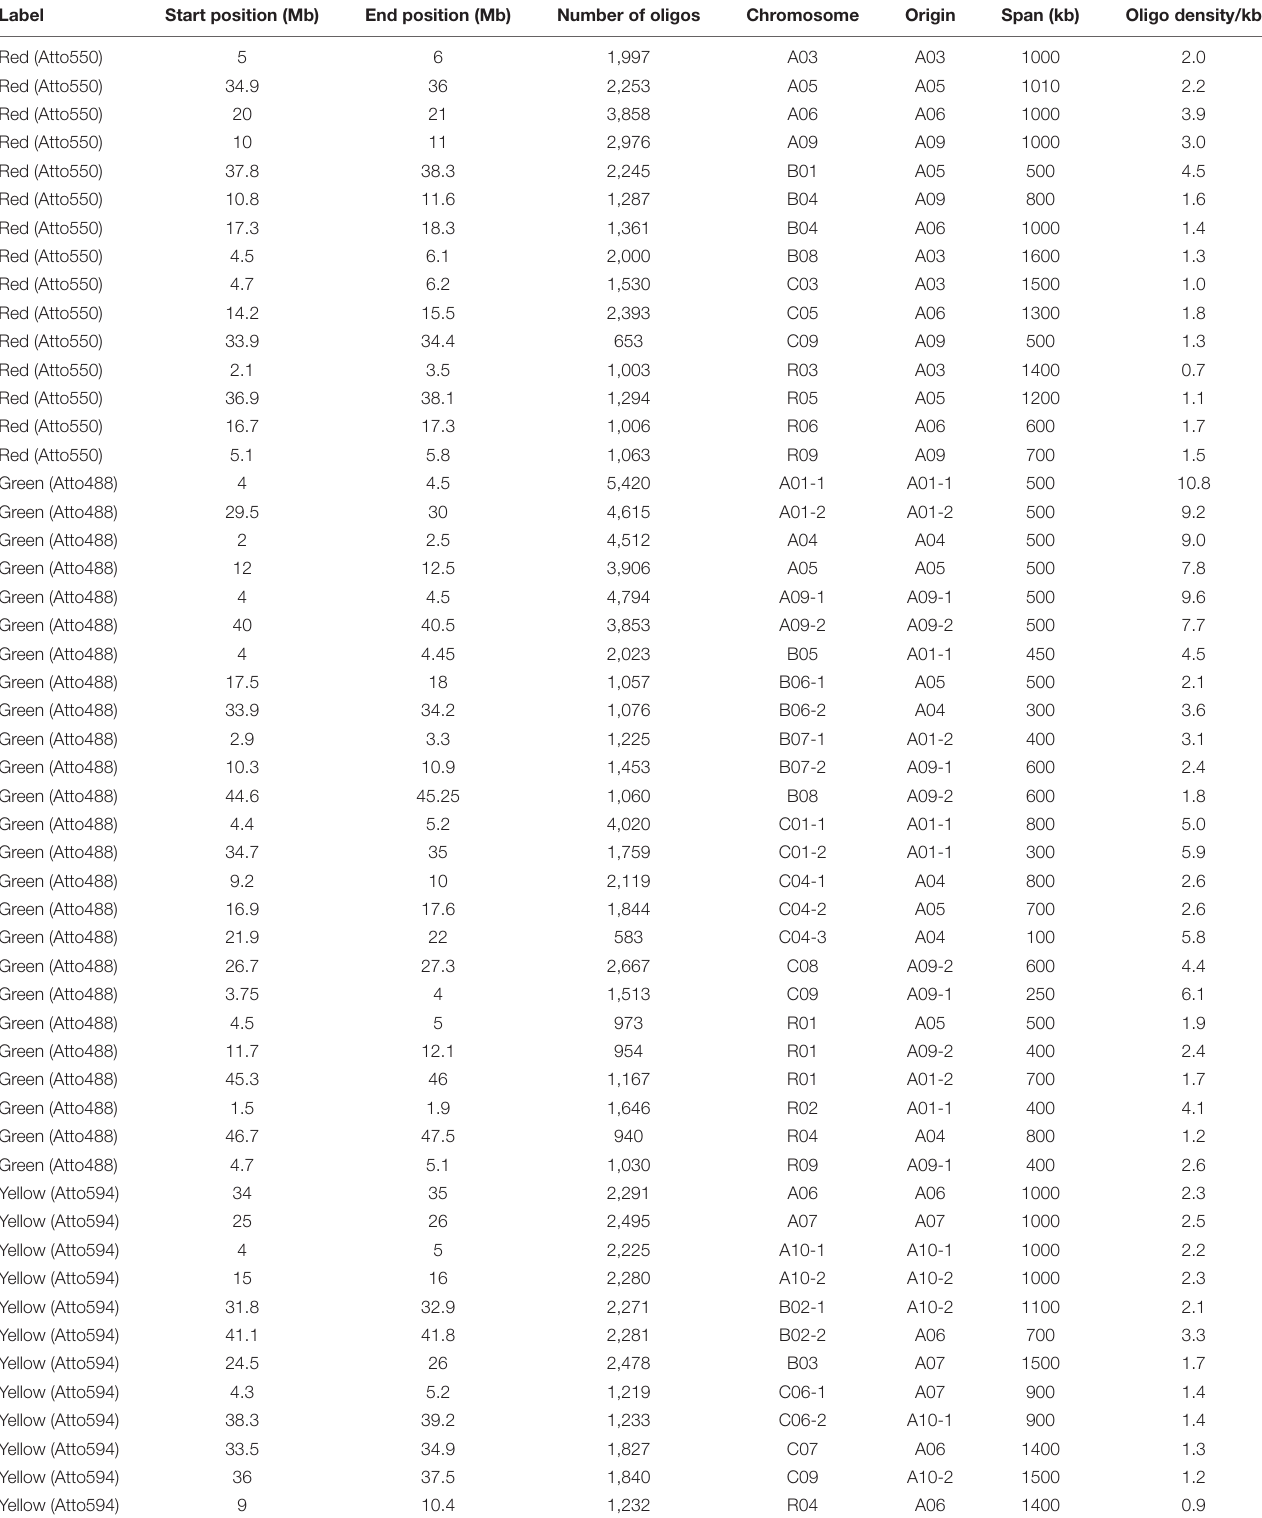
TABLE 1 | Details of design of synthetic massive oligonucleotide pools at each chromosomal locus (A, B, and C genomes and chromosomes number), with start and end position along the sequence and this span, the number of oligonucleotides (oligos) designed, density of oligonucleotides over the region, and fluorochrome label used.